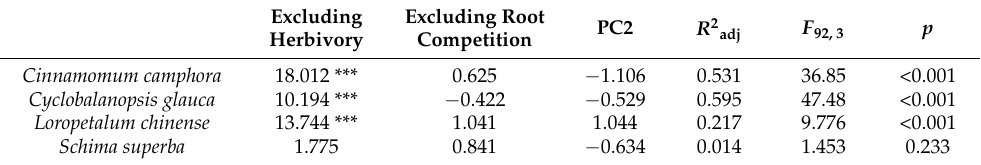
Table A1. The analysis of covariance (ANCOVA) results for four species. For the ANCOVA analysis, the dependent variables were the proportion of survived seedlings in each plot for each species, the independent variable was a categorical variable (treatment: control, excluding herbivory, and excluding root competition) and the PC2 was included as a covariate. The significance of the regression coefficients and the adjusted R-squared ( R 2 adj ) values are also presented. Significance level: *** p <